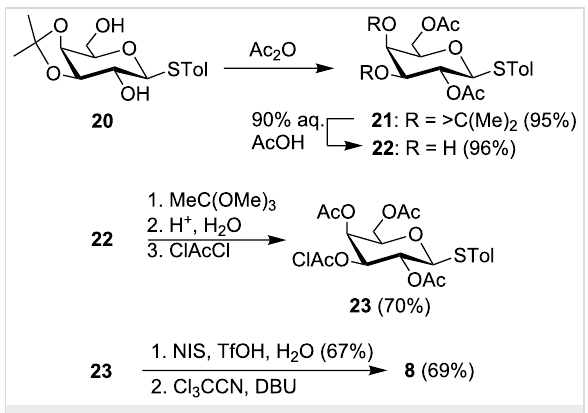
Scheme 2: Synthesis of the galactosyl donor 8